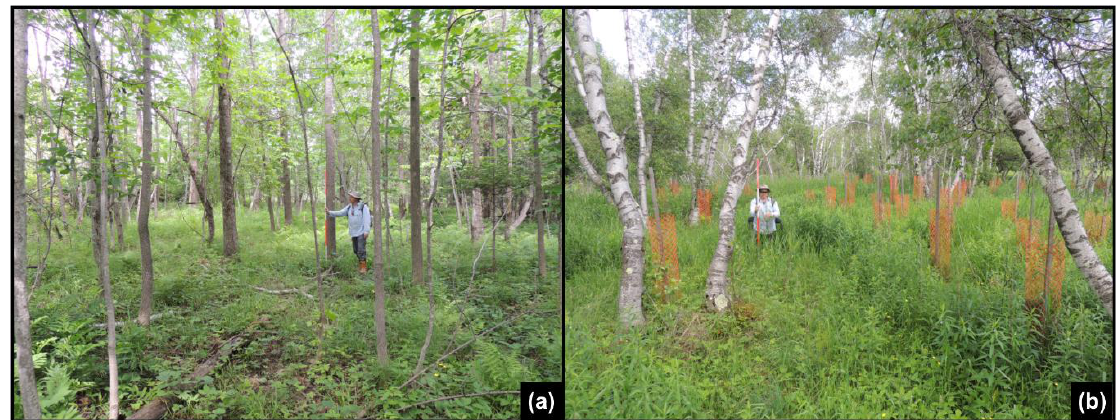
Figure 1. The two distinct forest community types used for underplanting: ( a ) the White ash community type and ( b ) the Grey birch-balsam poplar-elm community type.